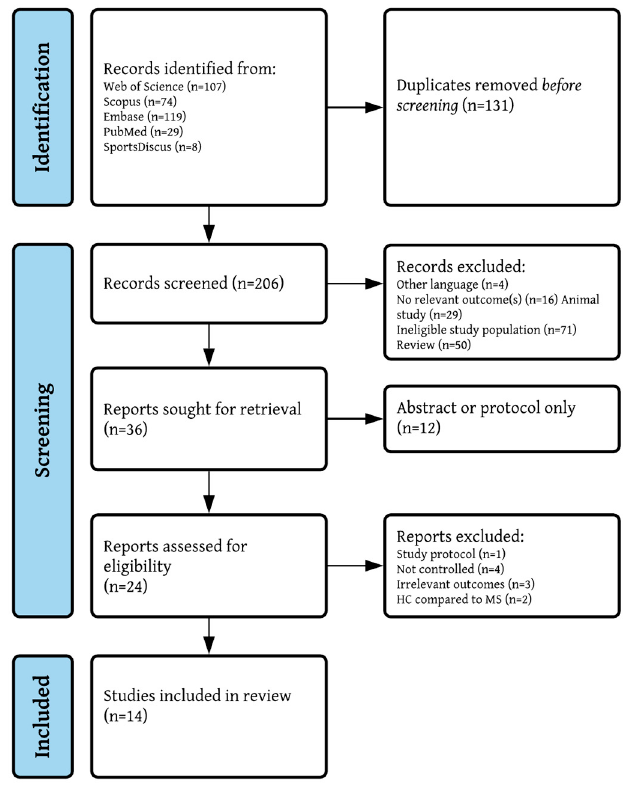
Figure 1. PRISMA Figure 1. PRISMA flowchart.